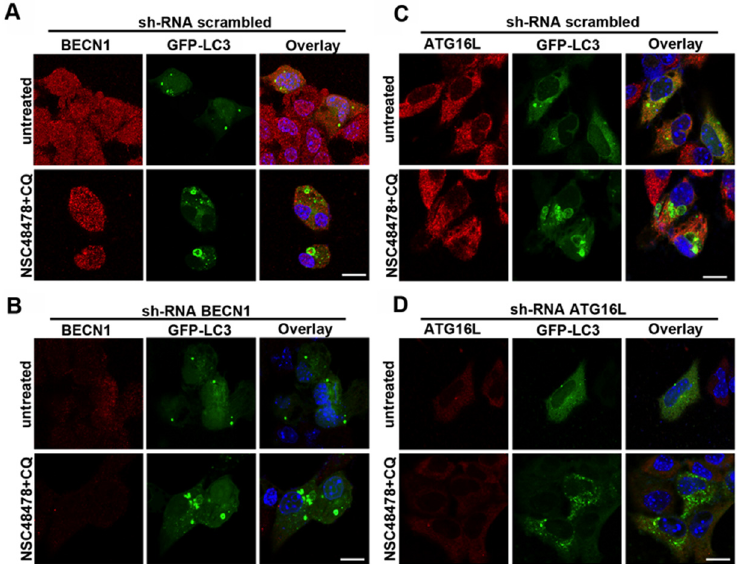
Figure 8. Effects of BECN1 and ATG16L1 knockdown on LC3-positive ring structures. GT1 cells were transiently transfected with specific shRNAs for BECN1 ( A , B ) or ATG16L1 knock down ( C , D ) and with GFP-LC3 (see methods for details). Cells were treated or not with NSC48478+CQ and processed for immunofluorescence analysis. Note the absence of LC3-positive ring structures in shRNA ATG16L1 (panel D ). ShRNA-GFP were used as scrambled (panels A , C ).